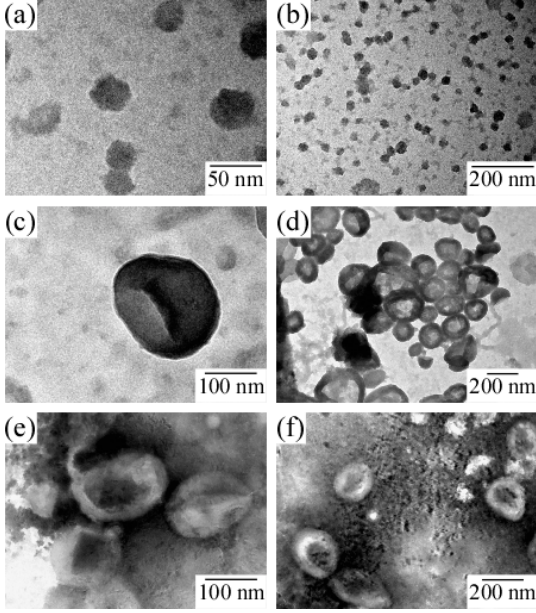
Figure 7. TEM images for PIC aggregates with f + values of ( a , b ) 0.4, ( c , d ) 0.6, and ( e , f ) 0.8.